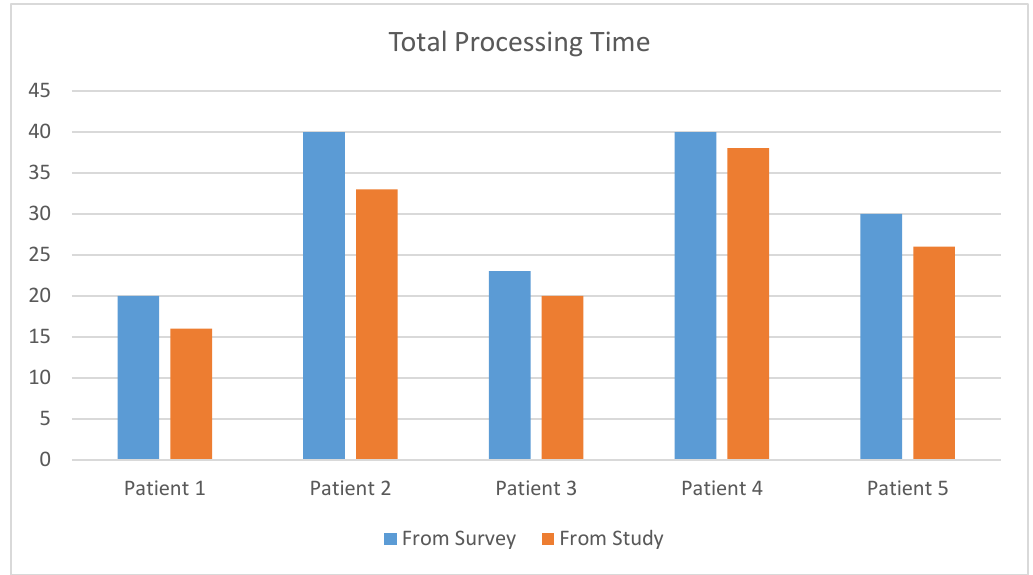
Figure 6. Graphical representation of the reduction of total processing